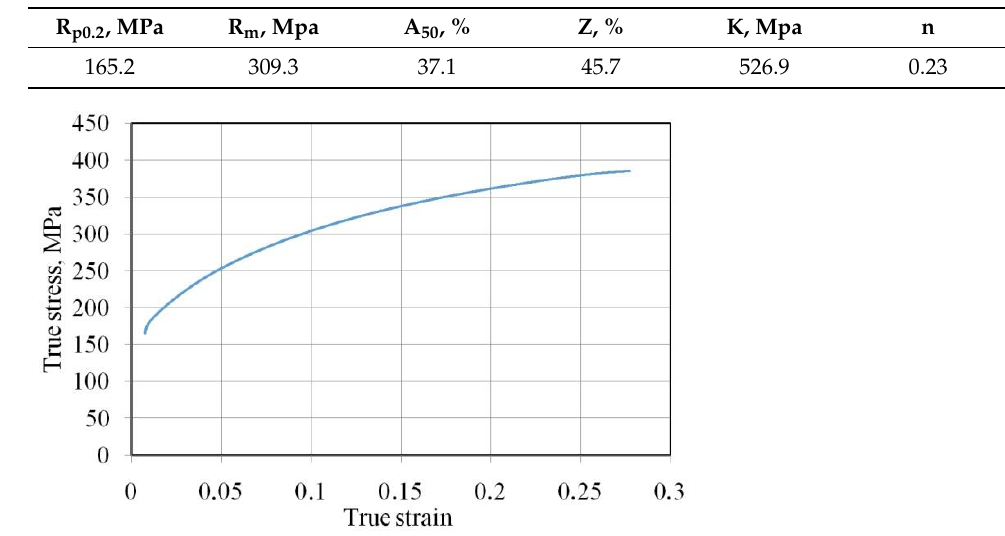
Table 2. Basic mechanical parameters of DC04 steel sheet.